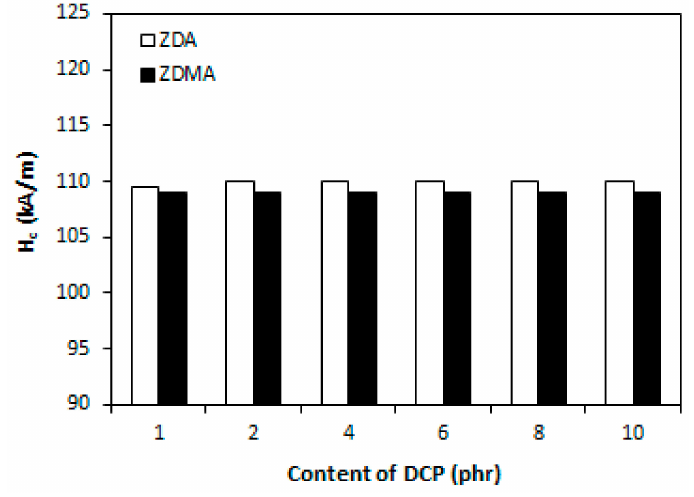
Figure 18. Influence of peroxide content on coercivity H c of composites.